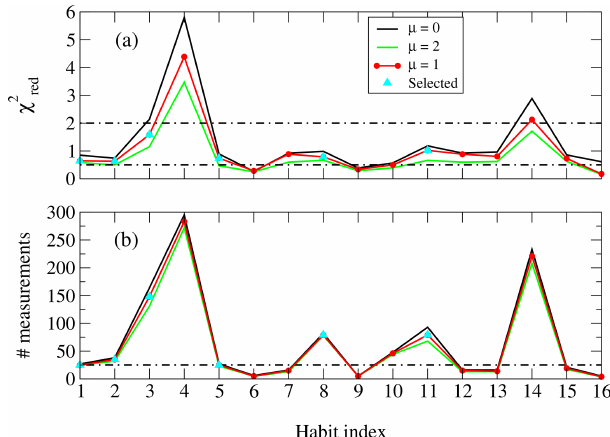
Figure 13. (a) Reduced χ 2 calculated from the Z e retrieved from red REFIR-PAD and those measured by the MRR by assuming µ = 0, 1, 2 , blue, red curves). (b) Number of measurements above the − 5dBZ threshold assumed for the analysis.